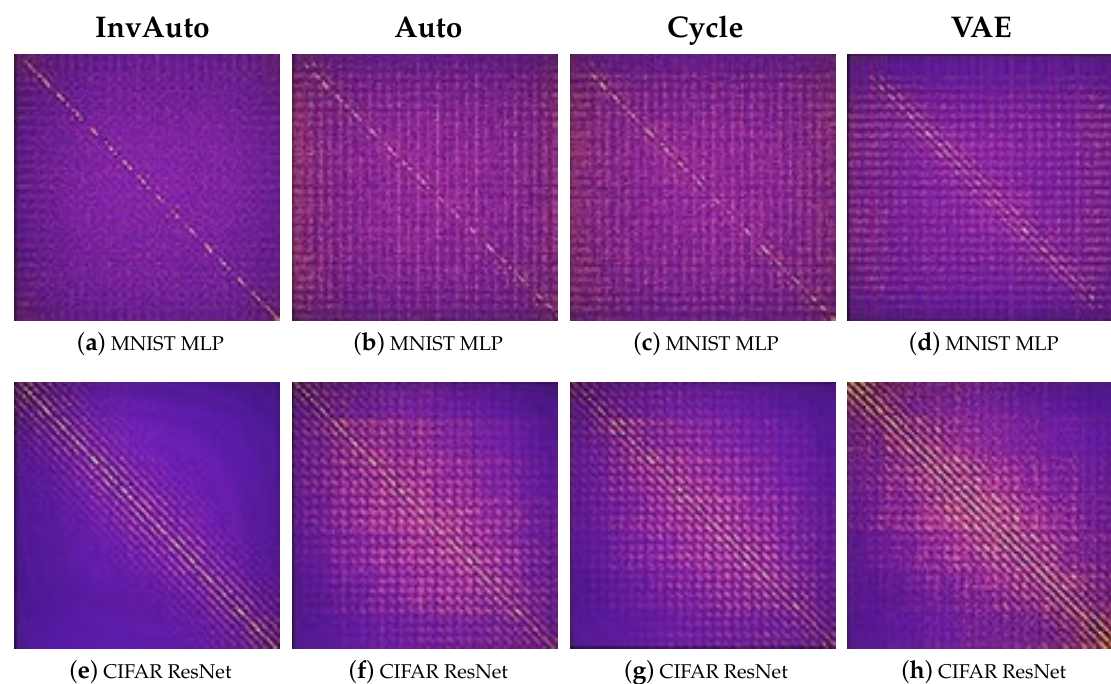
Figure 1. Heatmap of the values of matrix DE for InvAuto ( a , e ), Auto ( b , f ), Cycle ( c , g ), and VAE ( d , h ) on MLP and ResNet architectures and MNIST and CIFAR datasets. Matrices E and D are constructed by multiplying the weight matrices of consecutive layers of multi-layer encoder and decoder, respectively, e.g., E = E L . . . E 2 E 1 and D = D L . . . D 2 D 1 for a 2 L -layer autoencoder. In case of InvAuto, DE is the closest to the identity matrix.